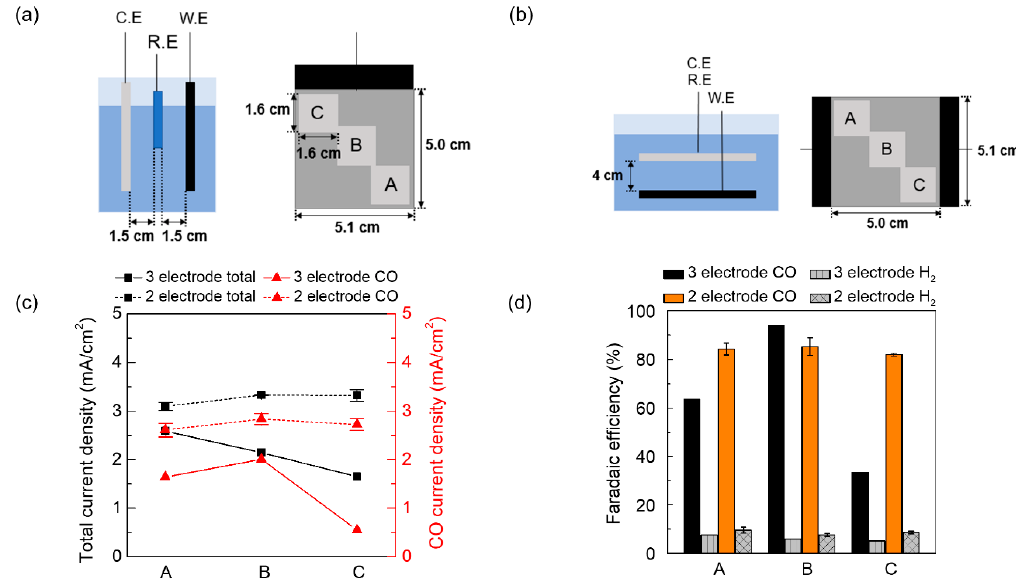
Figure 1. Schematic diagrams of the ( a ) vertical three-electrode system and ( b ) horizontal two-electrode system for fabricating the 25.5 cm 2 Ag gas di ff usion electrode (GDE). The sectioned positions used in the subsequent analysis were denoted as A, B and C. ( c ) Total electrolysis current density and CO production current density of the Ag GDE fabricated in each electrode system according to the position and ( d ) the corresponding FE for CO and H 2 . The Ag deposition conditions were − 0.49 V (vs. the saturated calomel electrode (SCE)) for 50 min in the three-electrode system, and 0.83 mA / cm 2 for 50 min in the two-electrode system. The CO 2 reduction was performed at a constant voltage of − 1.5 V (vs. SCE) in a laboratory-made H-type cell. 0.5 M KHCO 3 was used for both the anolyte and the catholyte.